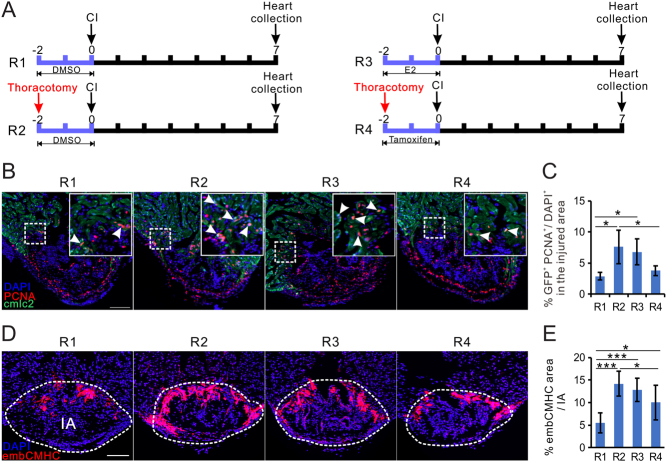
Estrogen preconditioning treatment promotes zebrafish heart regenerative process. (A) Experimental design of data presented in this figure. (B) PCNA immunofluorescence (red) in the heart of male Tg (cmlc2: eGFP) zebrafish heart from regimens R1-R4. Arrowheads in the white line bounded area indicate proliferating cardiomyocytes (PCNA+/GFP+). Scale bar: 100 μm. (C) Quantification of proliferating cardiomyocytes (PCNA+/GFP+) in panel B (mean ± s.d., n = 4~5). One-way ANOVA with LSD post hoc test, *P < 0.05. (D) embCMHC immunofluorescence (red) in the male heart from regimens R1-R4. (E) Quantification of embCMHC staining in panel E (mean ± s.d., n = 5~6) in the injured area. Scale bars: 100 μm. One-way ANOVA with LSD post hoc test, *P = 0.05, ***P < 0.001.